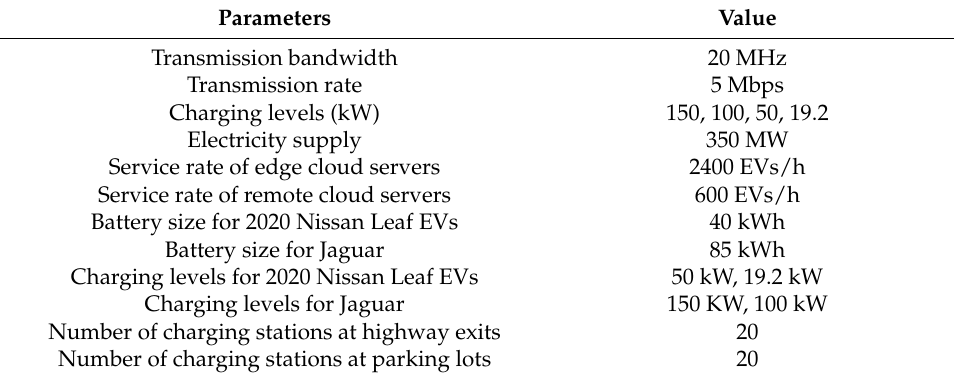
Table 2. Parameters and their